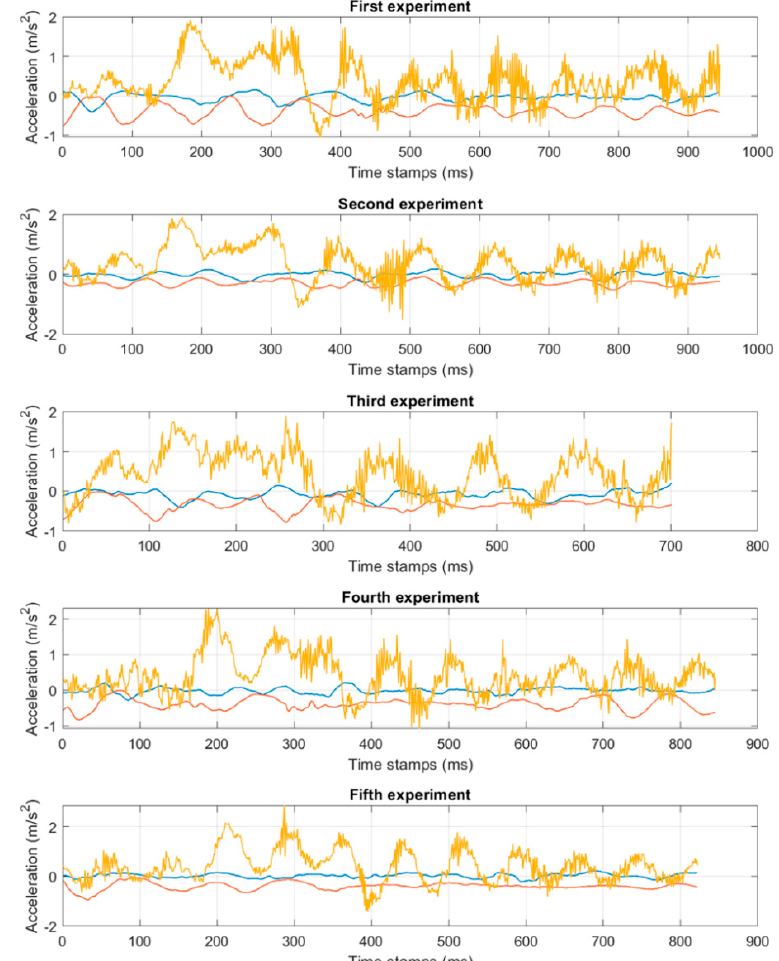
Figure 9. Results of the experimental measurements.